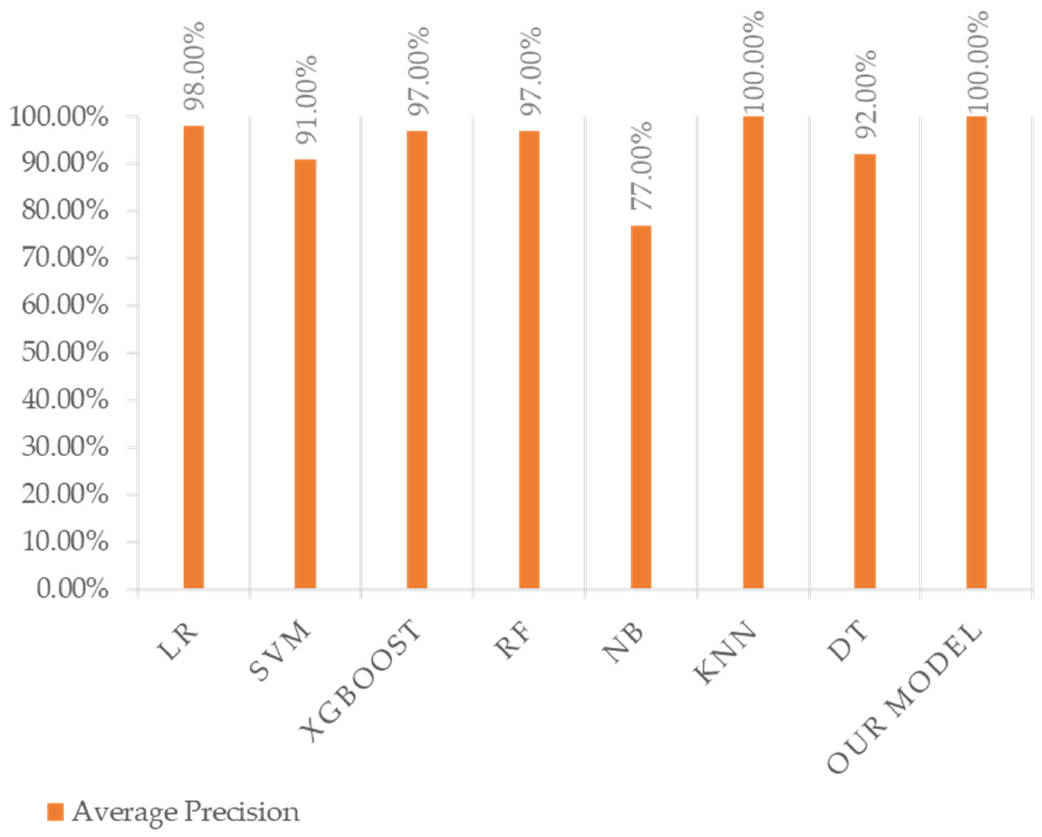
Figure A1. Comparison of the precision of our model with different algorithms.